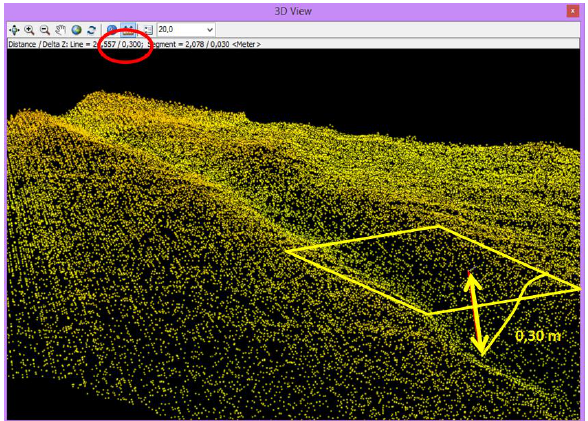
Figure 7. Anti-tank trench in the point